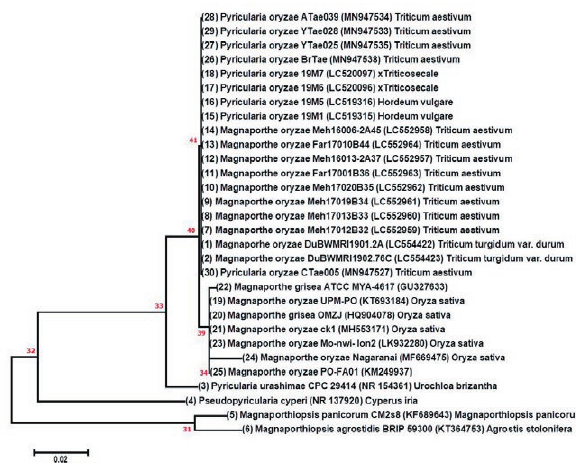
Figure 3. Neighbour-joining phylogenetic tree of Magnaporthe ory- zae isolates DuBWMRI1901.2A and DuBWMRI1902.76C with 28 related rDNA-ITS sequences from GenBank. Numbers at the nodes indicate bootstrap values generated from 1000 replicates, and the scale bar indicates the number of nucleotide